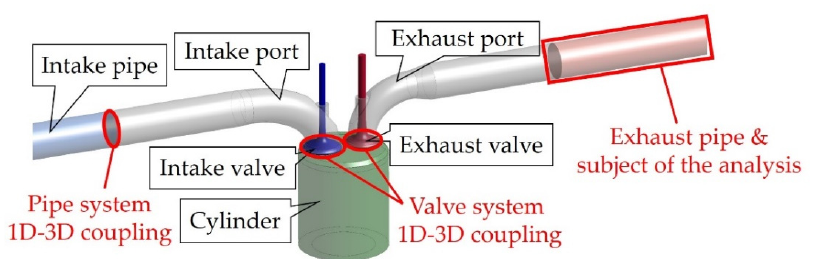
Figure 1. Modeling for numerical analysis of the gas flow in a diesel engine using the 1D–3D ap-